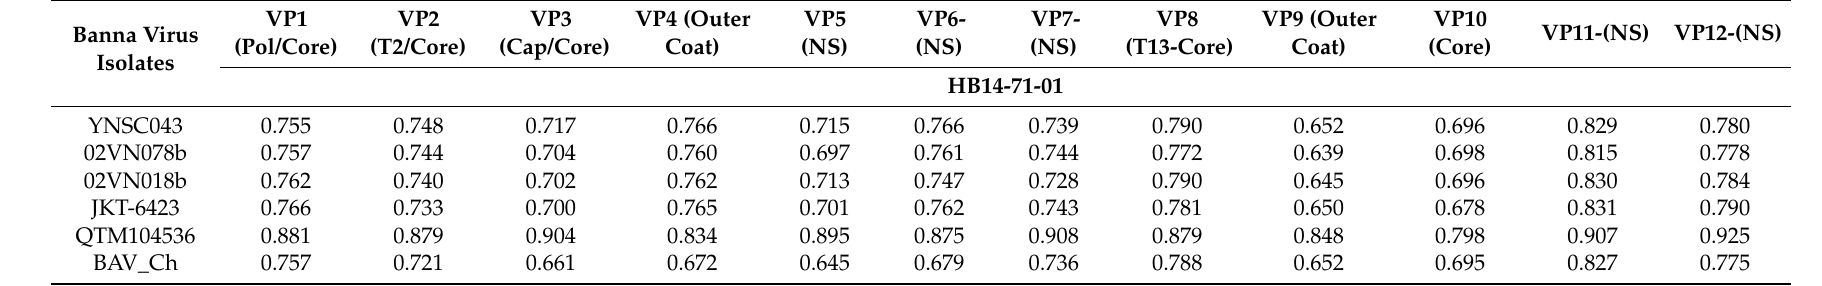
Table 2. Nucleotide sequence identity matrix for Banna viruses (BAVs).